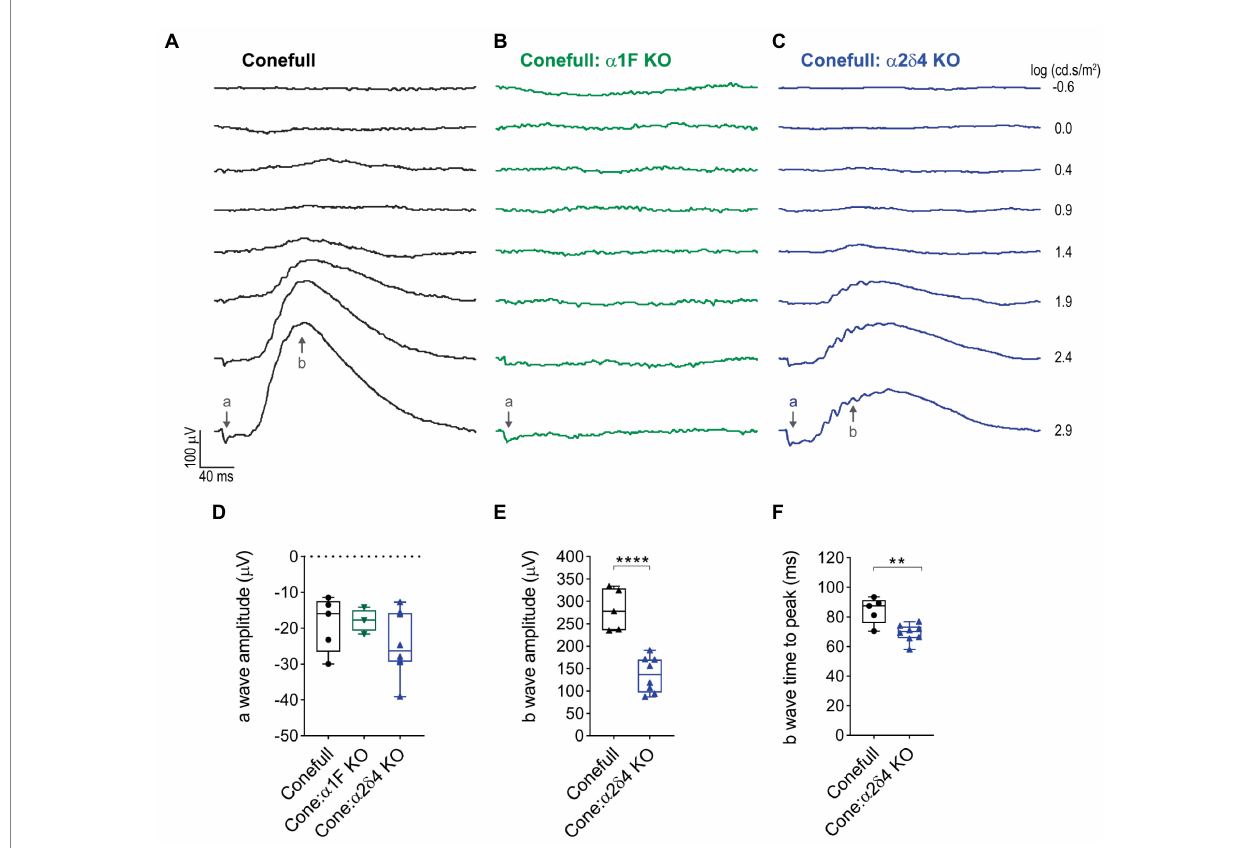
FIGURE 3 The no b-wave phenotype is present in Conefull: α 1F KO. (A) Flashes of increasing light intensity evoked a positive going b-wave response in Conefull animals beginning at 1.4 log (cd.s/m2) consistent with absence of rod function. (B) An a-wave but not a b-wave was elicited in Conefull: α 1F KO, green traces. (C) Both an a-wave and b-wave was elicited in Conefull: α 2 δ 4 KO, blue traces. (D) Comparison of a-wave amplitude, (E) b-wave amplitude and (F) b-wave time to peak in response to 2.9 log (cd.s/m2) flash intensity.